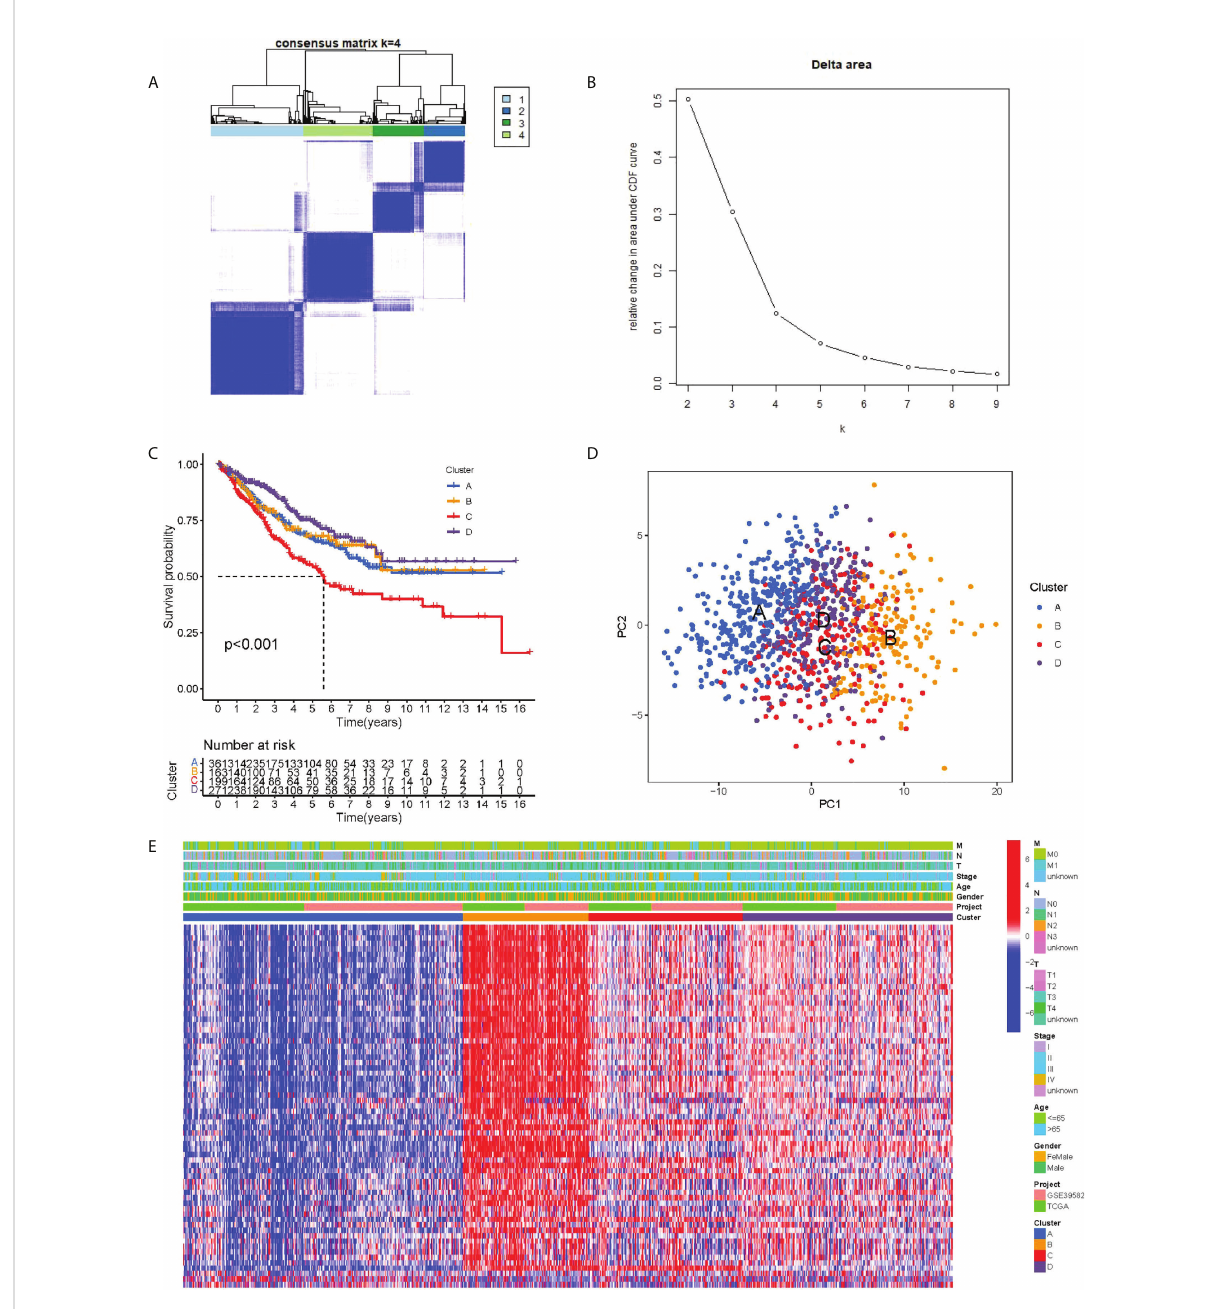
FIGURE 2 PRR subtypes. (A) Consensus clustering matrix when k = 4. (B) Relative change in area under the CDF curve for k = 2 through 9. (C) Kaplan- Meier curves of OS for four subtypes in COAD. (D) PCA analysis indicating an obvious difference in transcriptomes between the four subtypes. (E) Differences in clinicopathologic characteristics and expression levels of PRRs between the four distinct